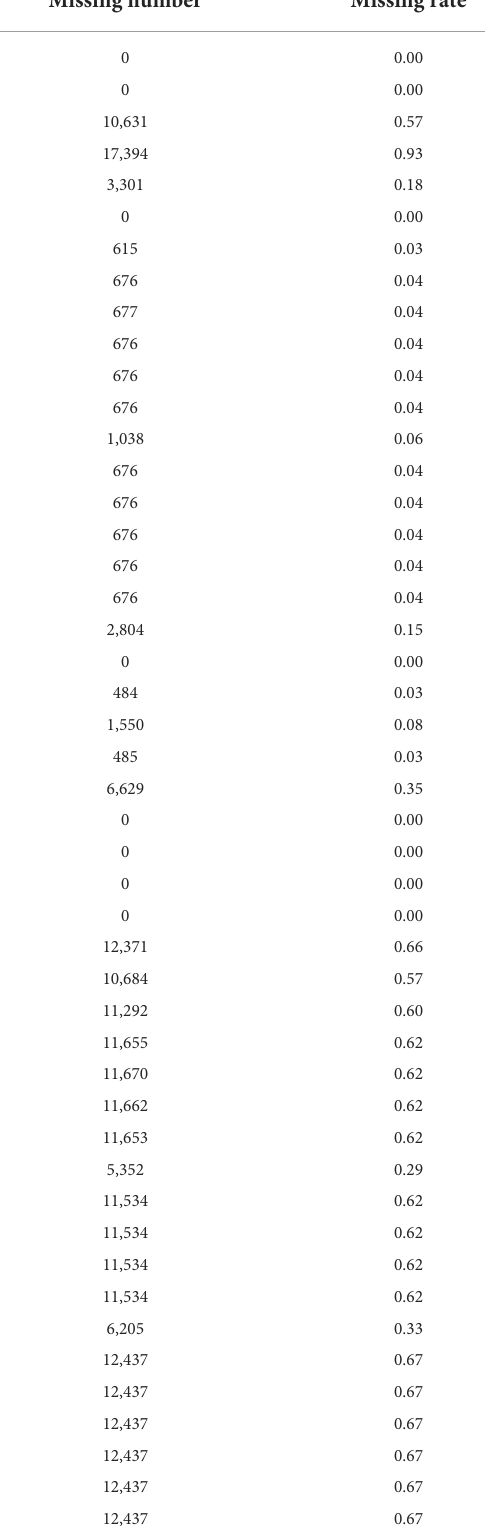
TABLE 3 Missingness of the studied